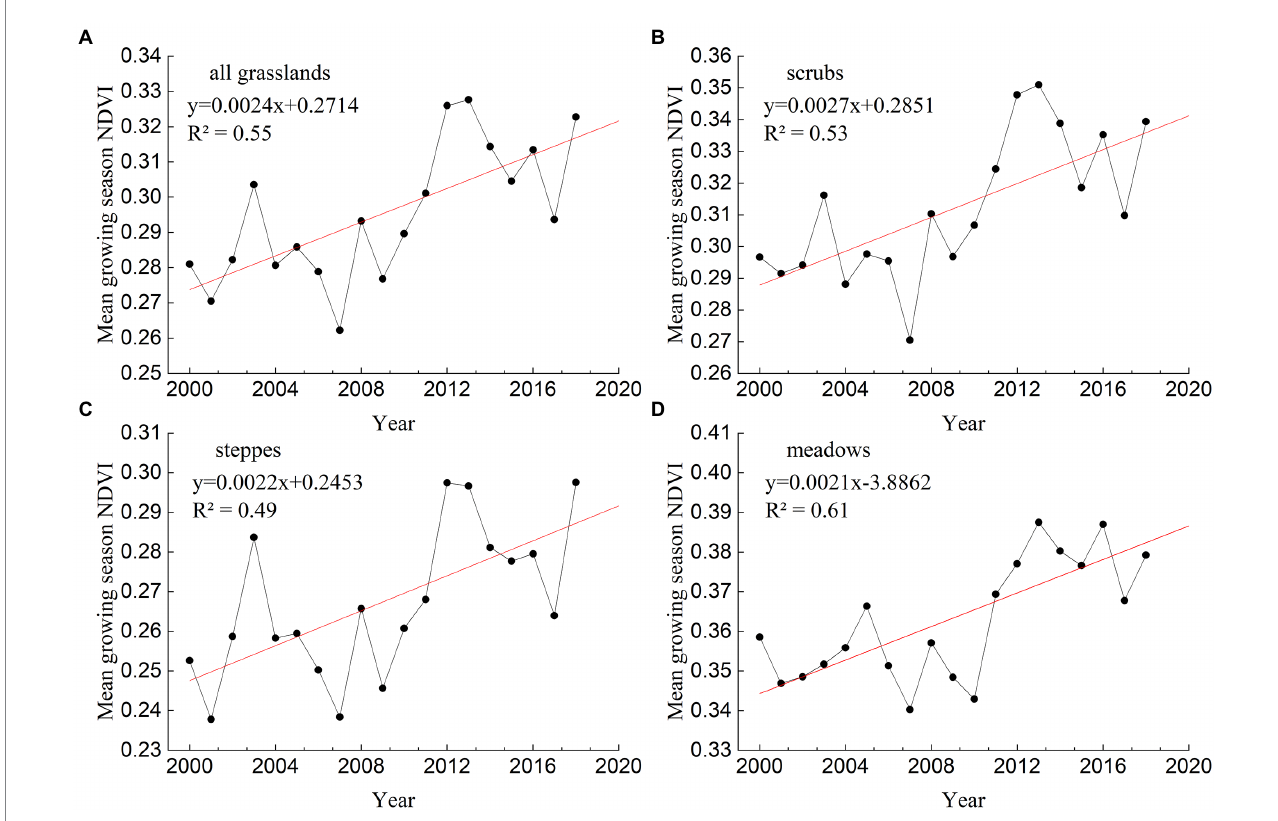
FIGURE 3 NDVI changes for different types of grassland vegetation on Mongolian Plateau during growing seasons from 2000 to 2018. (A) All grasslands, (B) scrubs, (C) steppes, (D) meadows.